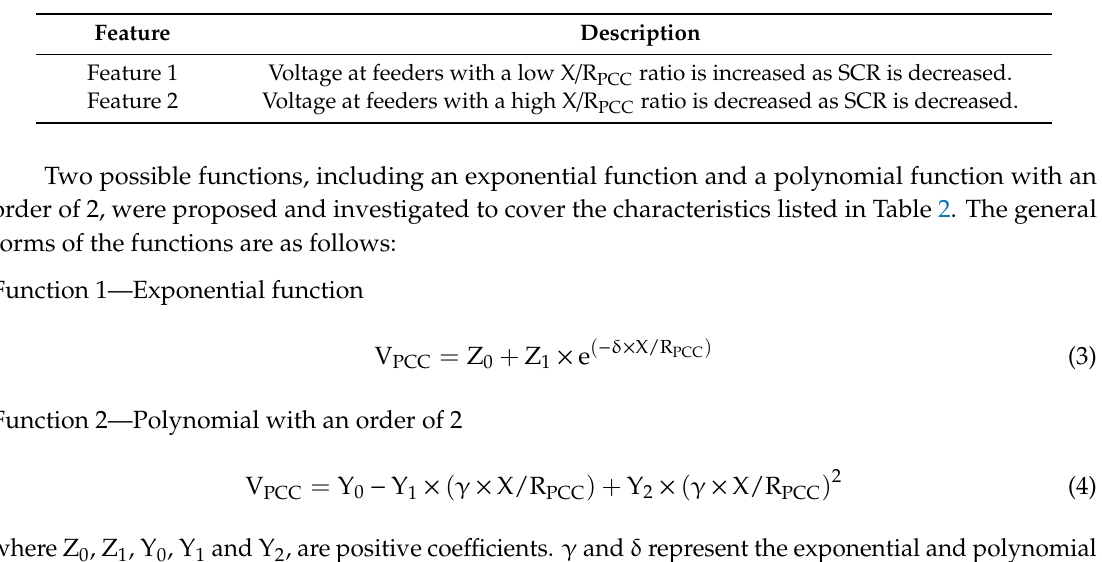
Table 2. Two main features considered for developing mathematical equations for IG-based Wind Power Plants (WPPs).